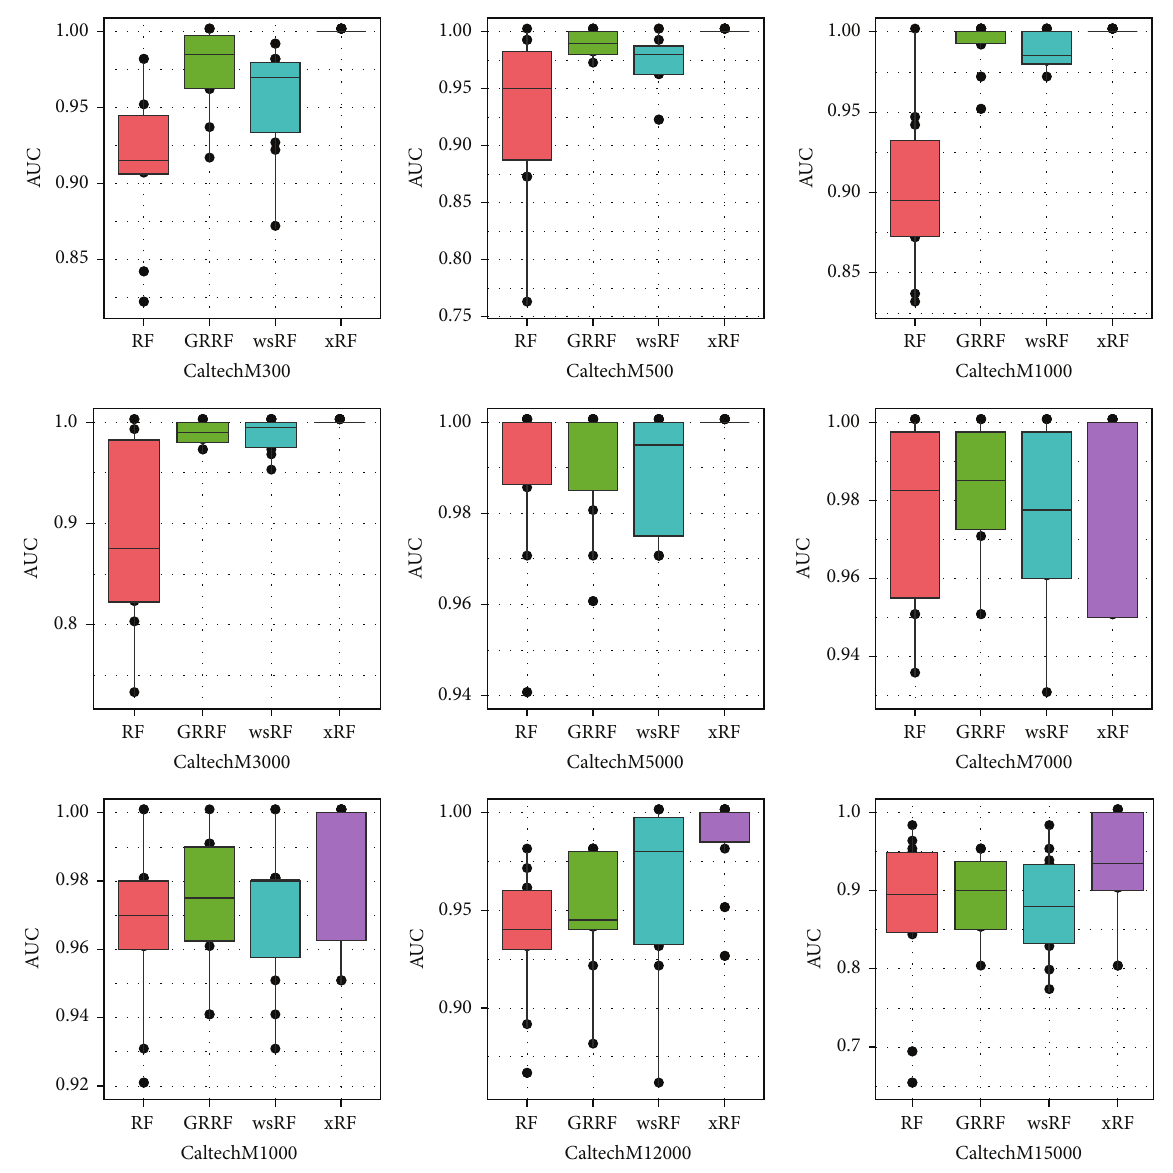
Figure 4: Box plots of the AUC measures of the nine Caltech